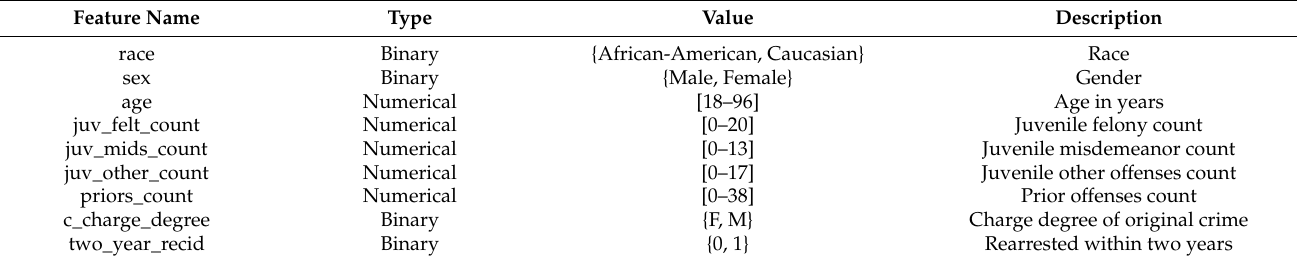
Table A1. COMPAS data set features adapted from [60].